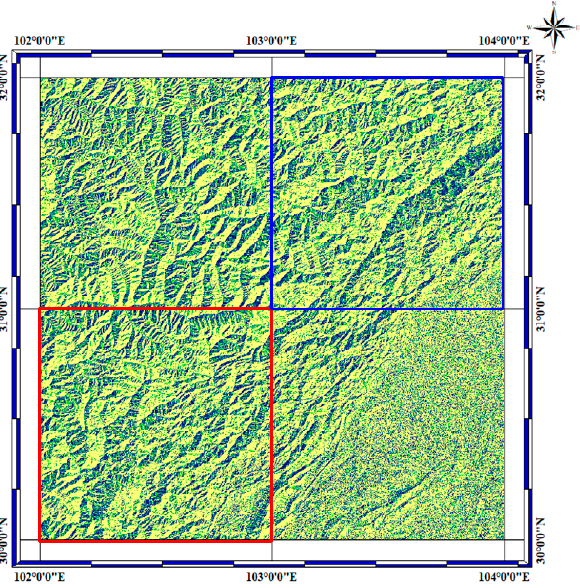
Figure 7. Distribution of the training and testing